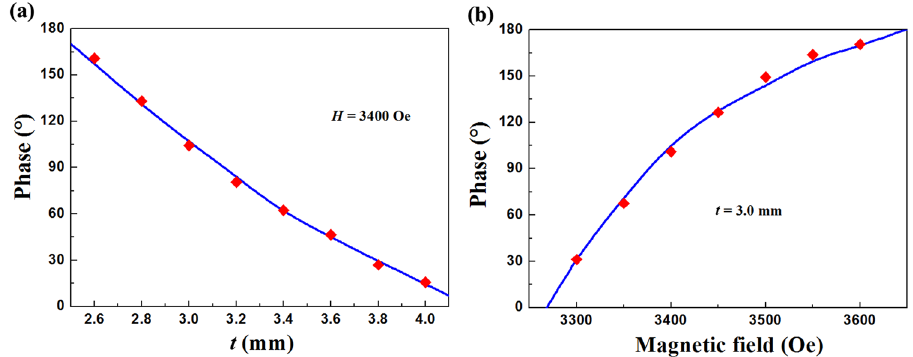
Figure 4. The dependence of phase difference at 11.0 GHz. ( a ) The dependence of phase difference on the ferrite rod thickness t and ( b ) the applied magnetic field H . The lines and dots represent the simulated and measured results, respectively.